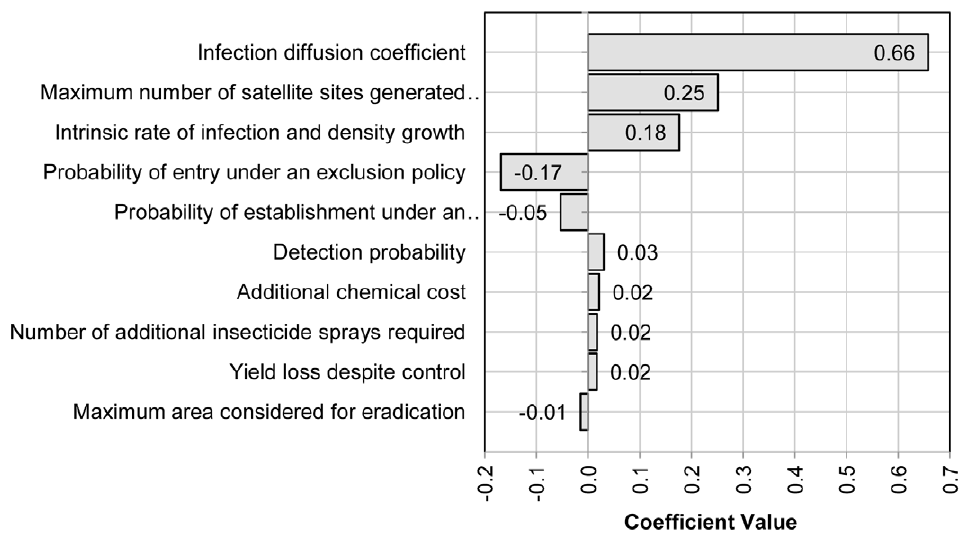
Figure 4. Sensitivity analysis.